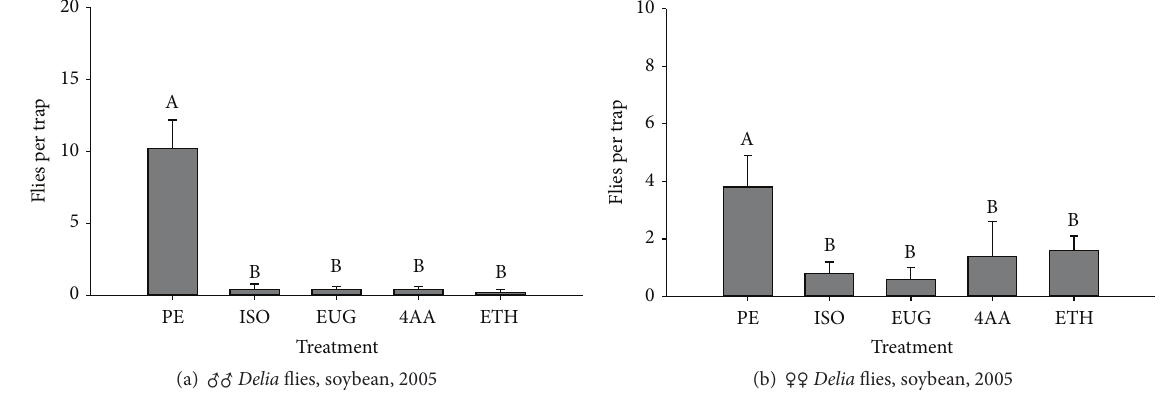
Figure 7: Mean number ( ± SE) of male (a) and female (b) Delia flies captured on sticky traps baited with volatile chemical, Jul 20–22, 2005, in a soybean plot near Brookings, SD (test #7). For each sex, bars without the same letters above them indicate that the means differ significantly. PE = 2-phenylethanol, EUG = eugenol; ISO = isoeugenol; 4AA = 4-allylanisole, and ETH = ethanol (control), each at 100 mg on a cotton roll.